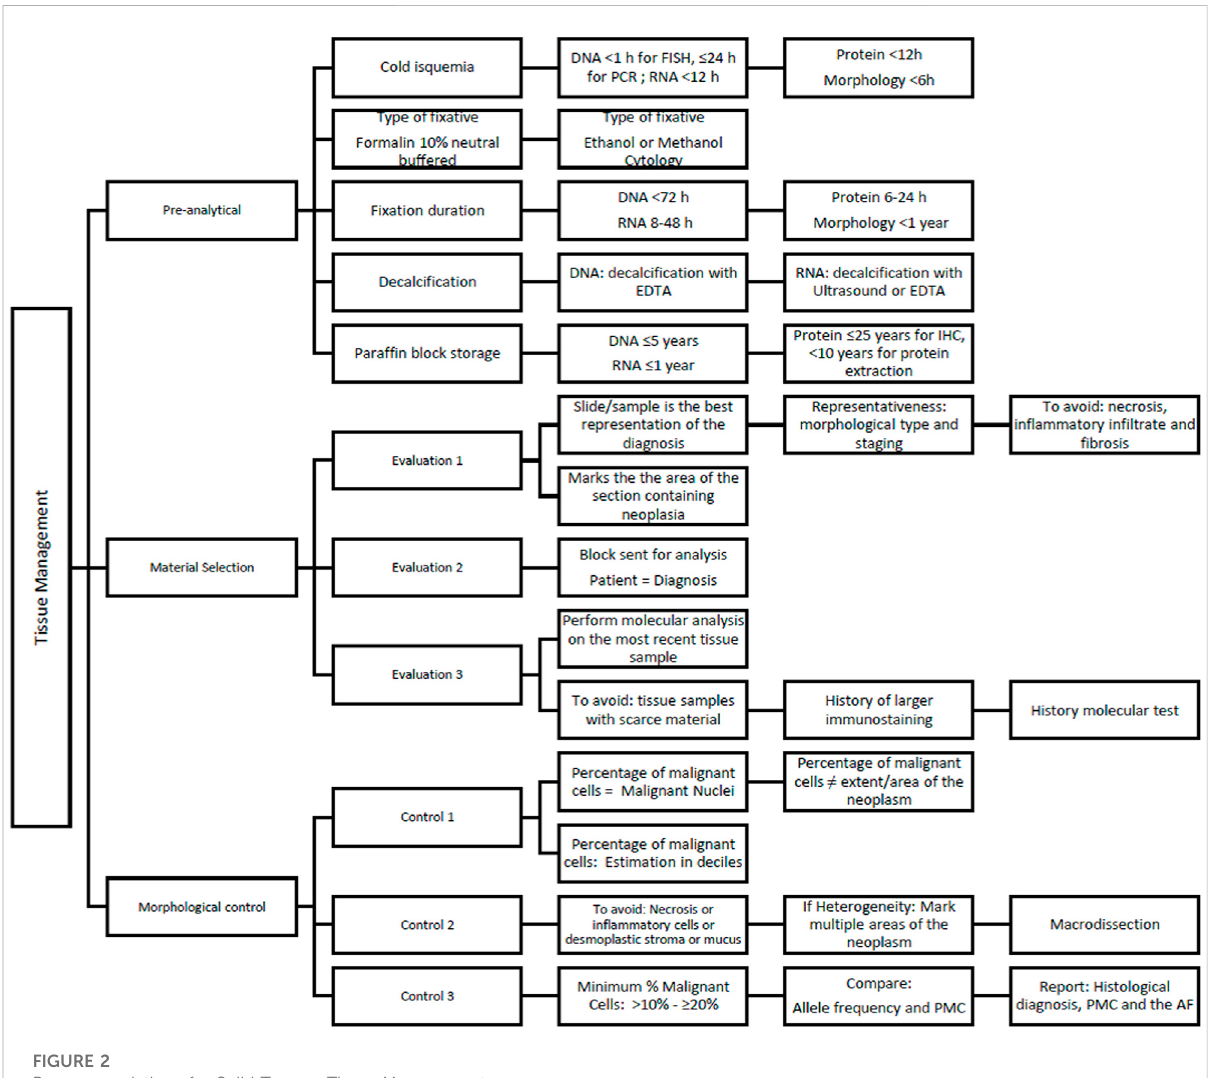
FIGURE 2 Recommendations for Solid Tumors Tissue